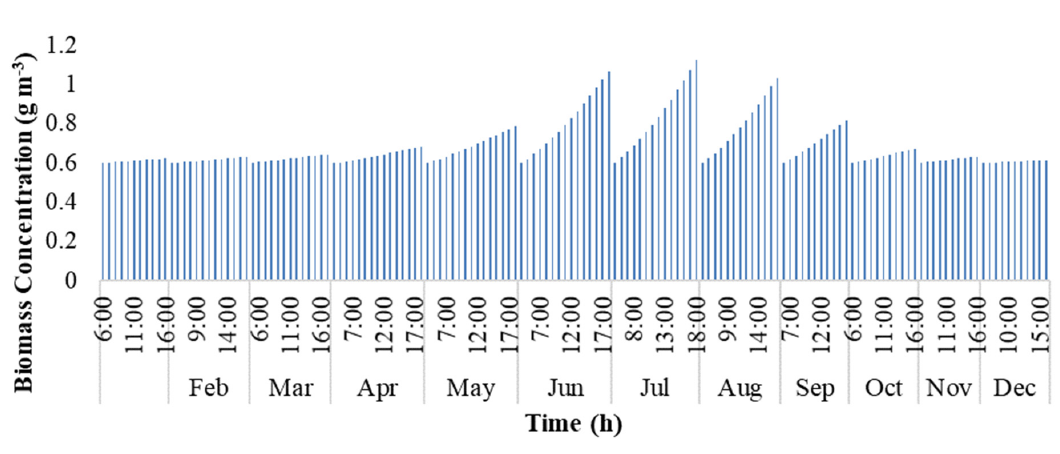
Figure 13. Change in biomass concentration with time inside the Raceway Pond for Kay County.